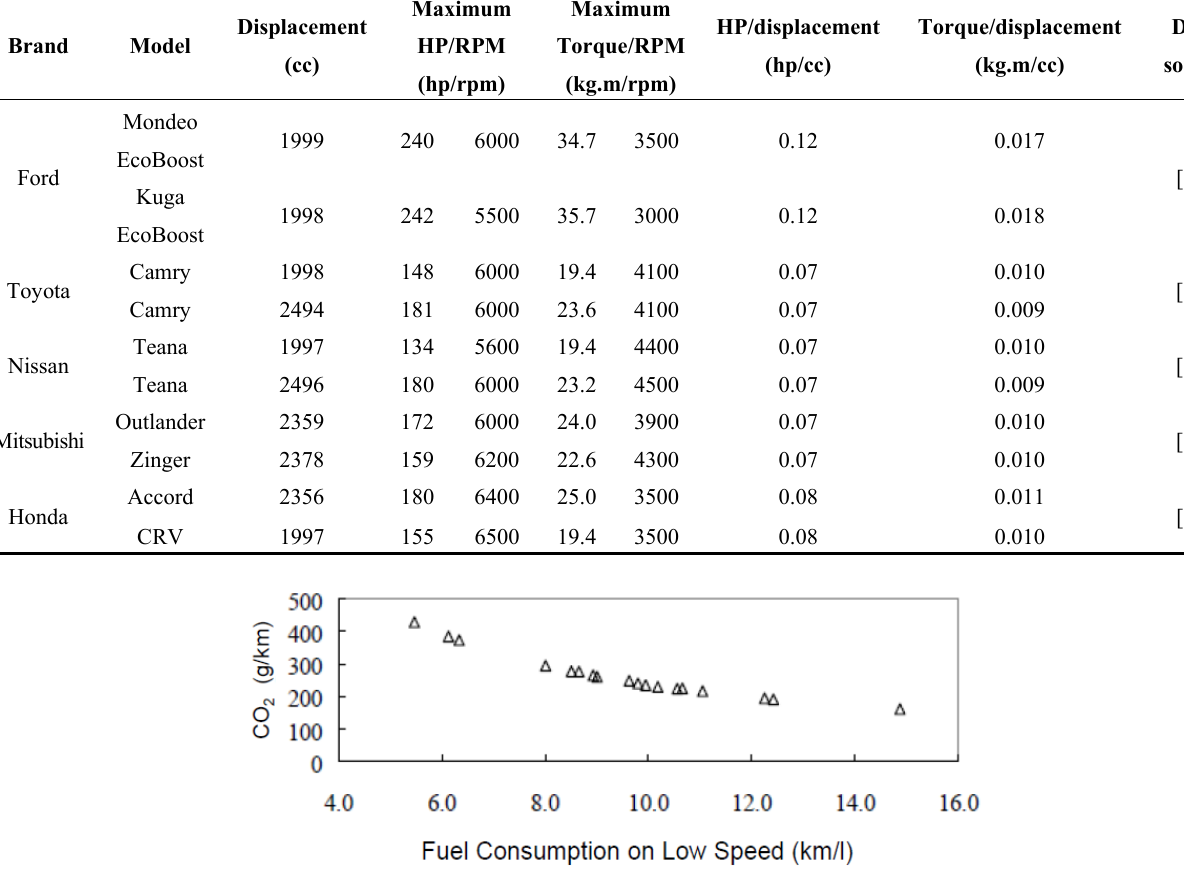
Figure 6. The fuel consumption vs . CO 2 emission on low speed. Source